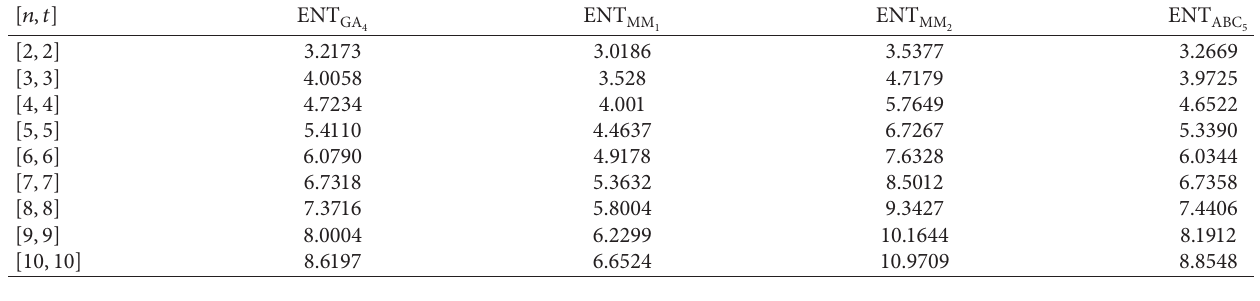
Table 10: Comparison of eccentricity-based entropies ENT